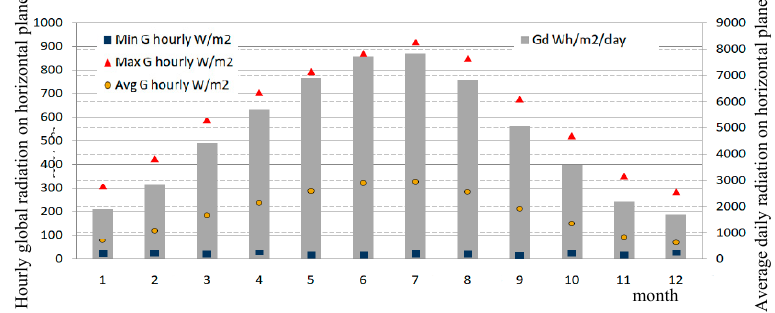
Figure 1. Minimum, maximum and average value for the hourly global radiation on horizontal plane (G—left axis) and average daily radiation on horizontal plane (Gd—right axis)